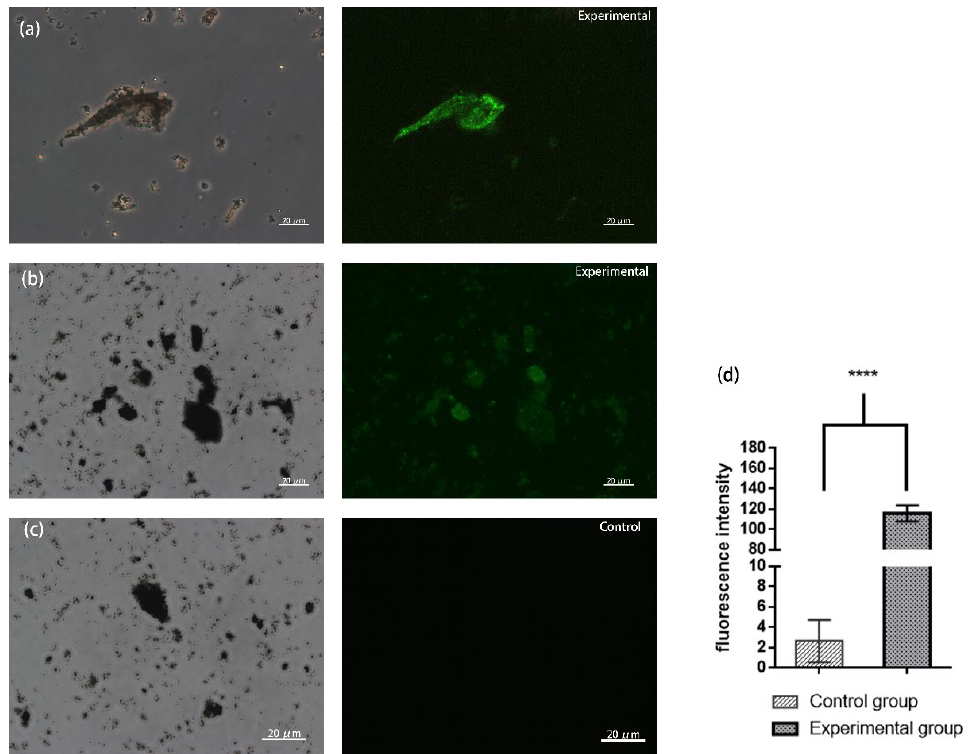
Figure 6. IMB after capturing the pseudoviruses: ( a , b ) fluorescence microscope photos of the experimental group; ( c ) fluorescence microscope photos of the control group; ( d ) fluorescence intensity of experimental group and control group measured by microplate reader (**** p < 0.001).